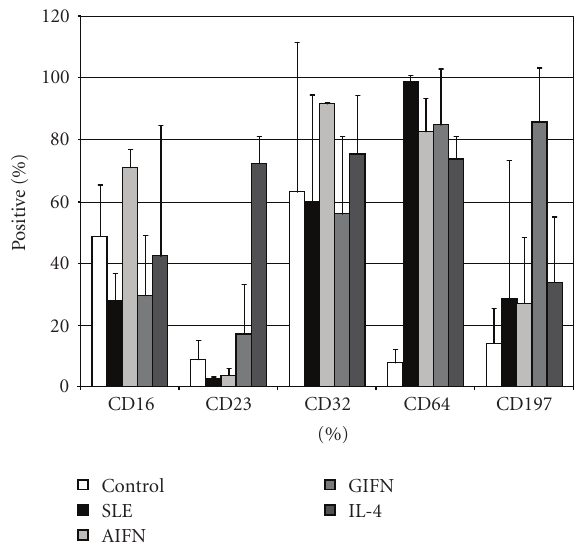
Figure 1: Cell surface markers are altered in SLE and cytokine-treated monocytes. Control monocytes were either mock treated or treated with the indicated cytokines for 18 hours ( n = 3). The SLE cells were studied without any intervention ( n = 4). In each case, the cells were gated on physical parameters and CD14 expression. The SLE monocytes have statistically significant di ff erent expression of CD16 compared to the α IFN-treated